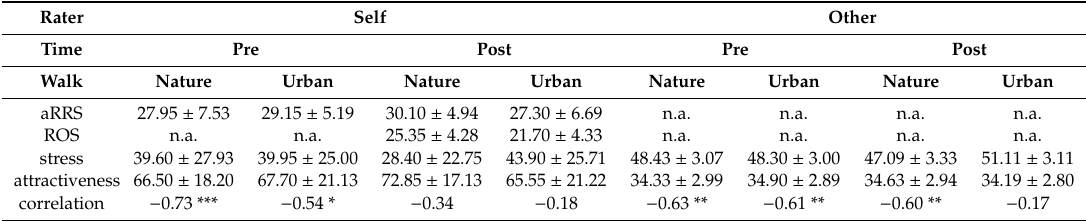
Table 1. Mean ± SD of dependent variables, as well as correlation between stress and attractiveness